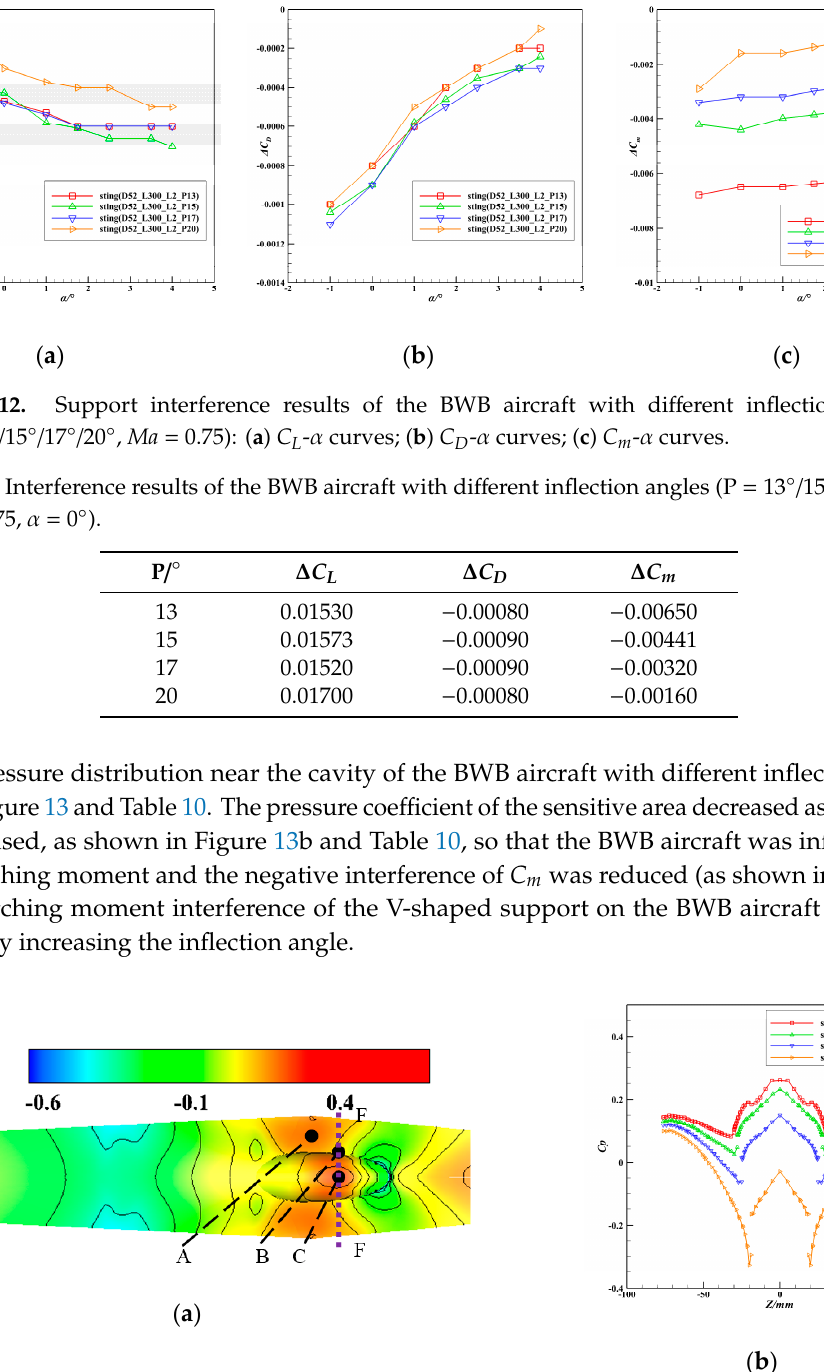
Figure 14. Sensitivity comparison of Δ C m with different geometric parameters ( Ma = 0.75, α = 0°).